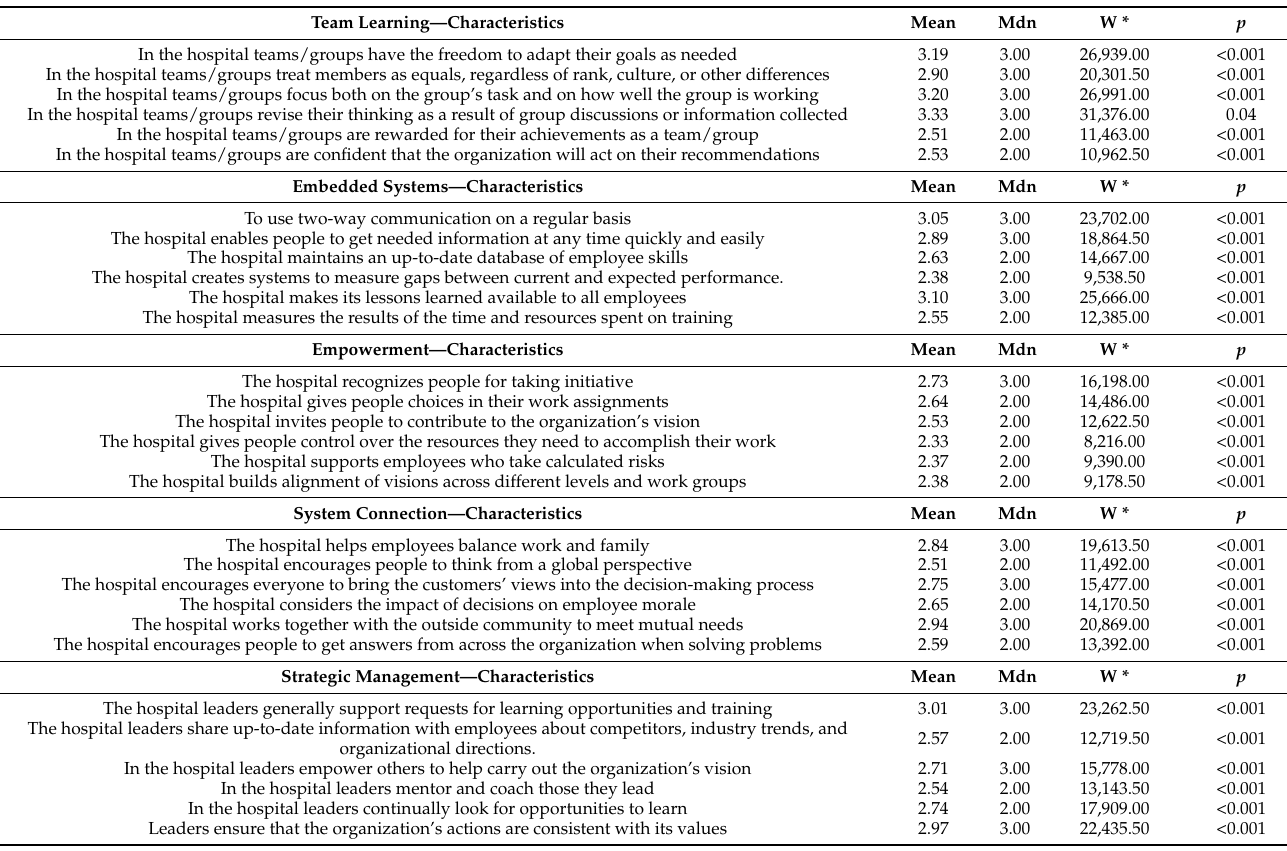
Table 6. Comparison of the individual characteristics of: (a) Team Learning, (b) Embedded Systems, (c) Empowerment, (d) System connection and (e) Strategic Leadership dimensions with the use of the one-sample Wilcoxon sign rank test. Team